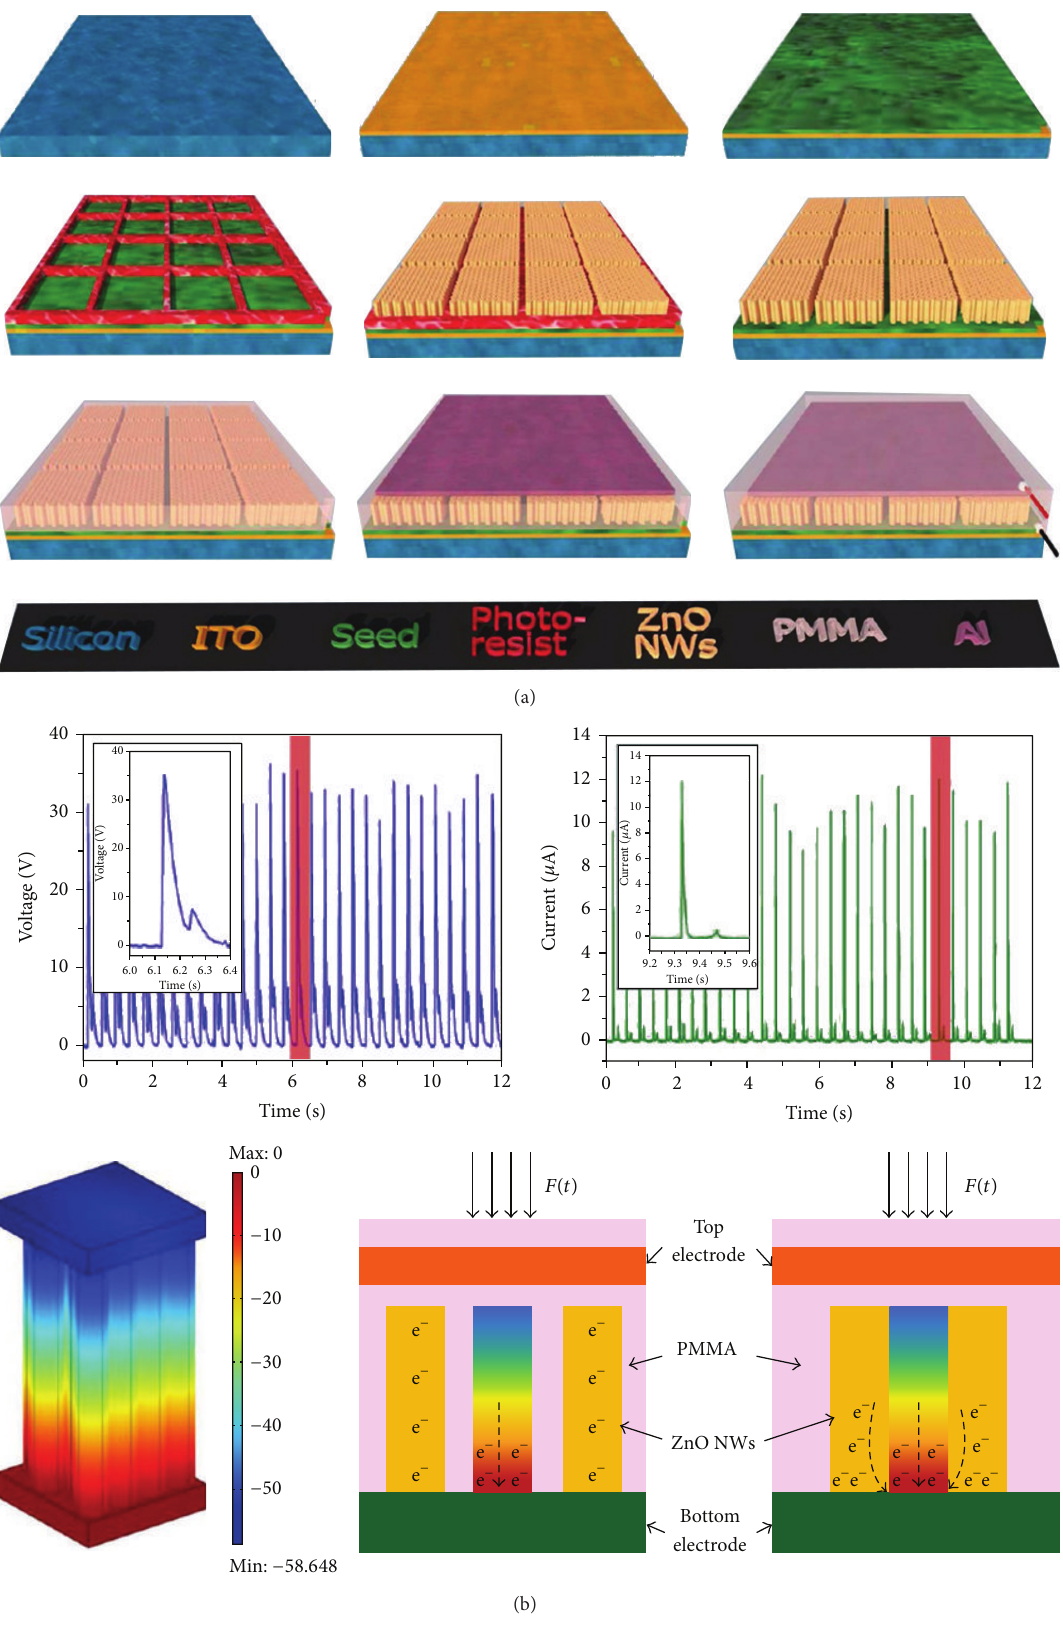
Figure 6: (a) The fabrication process of the segmented ZnO nanowire VINGs. (b) The generated electrical signal and FEM simulation results. [Reproduced from [39] with the permission of American Chemical